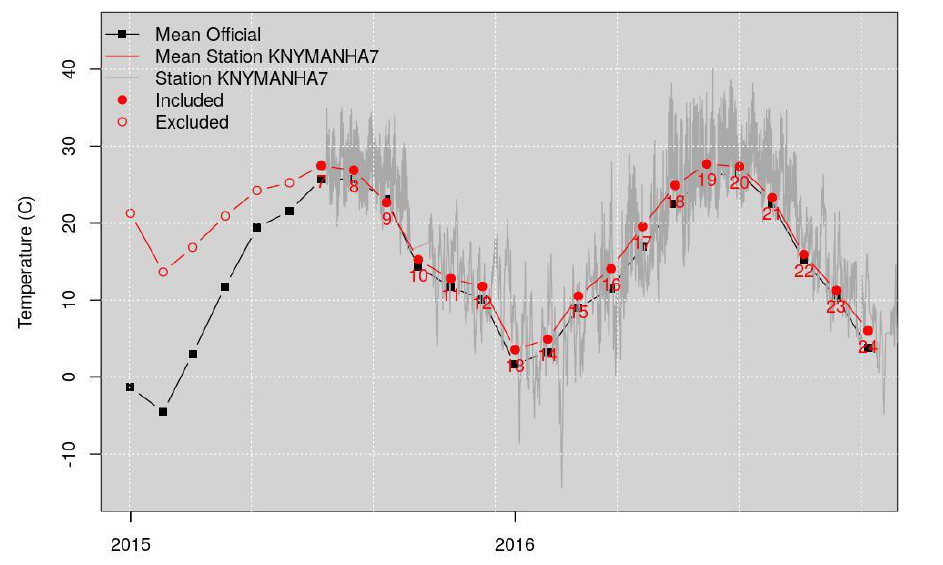
Figure 3. WU data quality control—Monthly temperature of station KNYMANHA7. The black line represents the monthly mean temperature of the stations. The red line represents the monthly mean temperature of station KNYMANHA7. The grey line shows the daily temperature of station KNYMANHA7. The time steps correspond to each month. The red filled points represent the time steps included in the analysis (the monthly mean temperature deviation is within the 3 °C threshold); the red circles represent the time steps excluded, because their monthly mean temperature deviates more than the